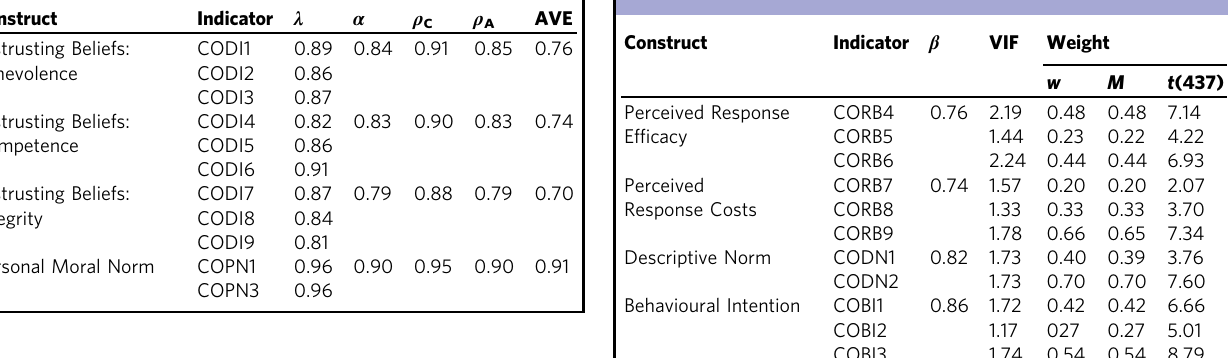
Table 1 Evaluation of the re fl ective measurement model: Loadings λ (original estimate), internal consistency reliability ( α , ρ C , ρ A ) and convergent validity (AVE).